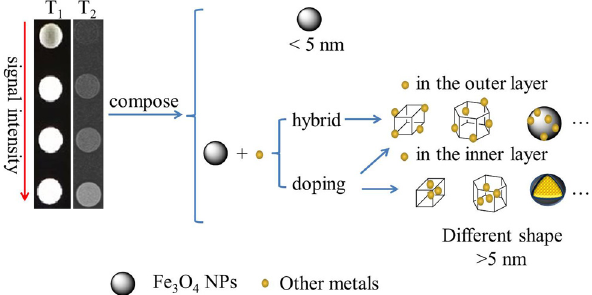
Figure 4: Composition and current situation of dual modulus